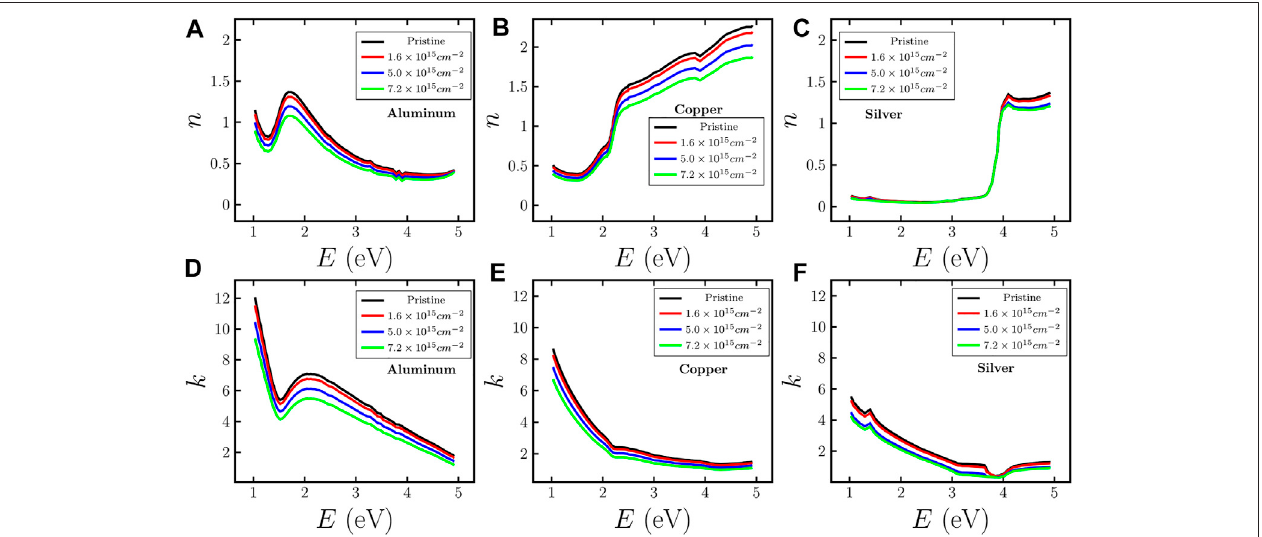
FIGURE 4 | Variation of real and imaginary parts of the refractive index for aluminum [ (A , D) ], copper [ (B , E) ], and silver [ (C , F) ], respectively, with energy of incident lightas well as varying fl uence of Argon ions. Black solid line represents the data obtained from KK technique and colored (red, blue, and green) solid lines represent the data obtained from MG